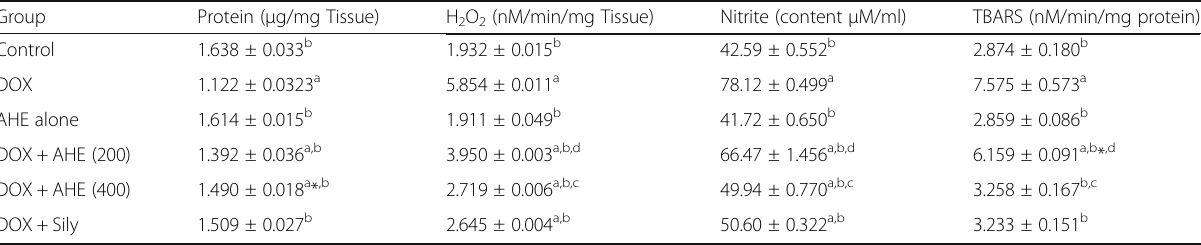
Table 6 Effect of Doxorubicin (DOX) and different treatments of AHE on cardiac tissue protein, H 2 O 2 , nitrite content and lipid peroxidation Group